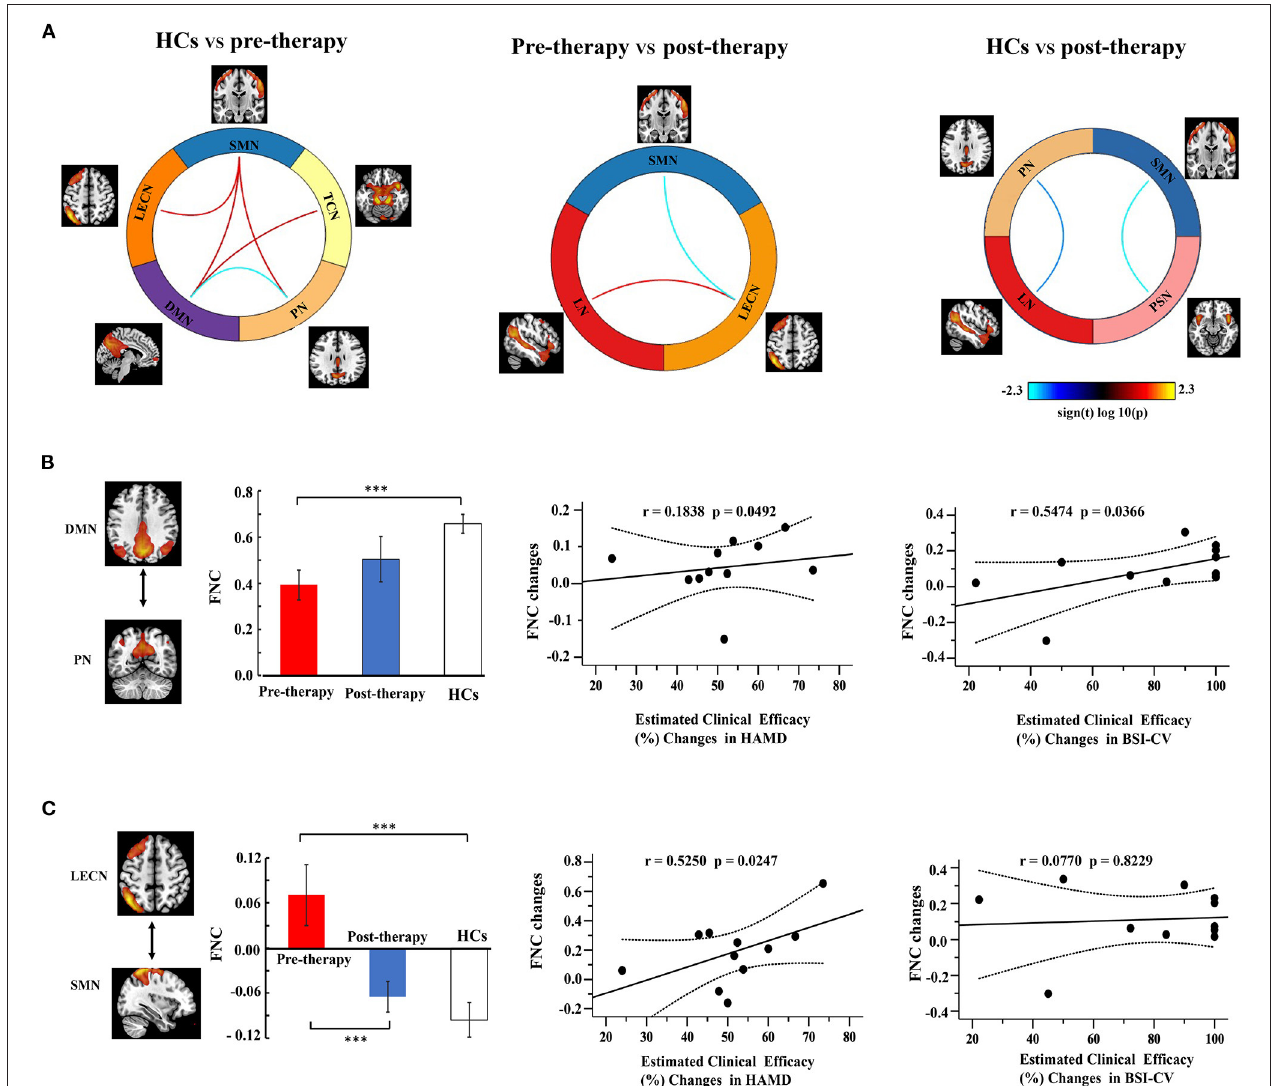
FIGURE 5 | Function network connectivity (FNC) between RSNs. (A) FNC differences in the selected FNC. The blue line indicates a decreased FNC and the red lines indicates improved FNC ( P < 0.05). (B,C) shows the relationships between the FNC and clinical efficacy. Error bars indicate the standard error. Dotted lines indicated the significantly changes of groups. * p < 0.05. ** p < 0.01. *** p <